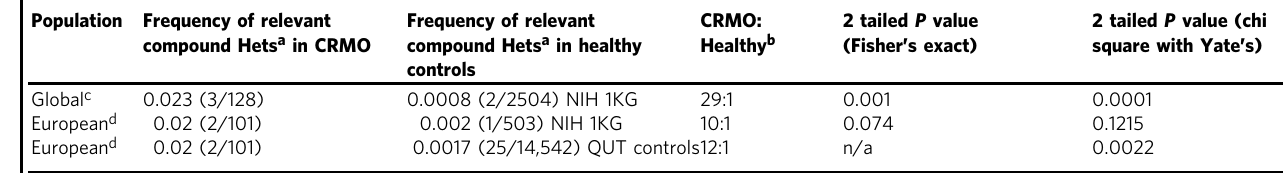
a Combinations of R146Q – rs34515646, S132P – rs35589326 and G202*V – rs144526386 (Fig. 5e). b Frequency ratio rounded to nearest whole number. c CRMO patients and healthy controls of all ancestries included. d CRMO patients and healthy controls of only European descent